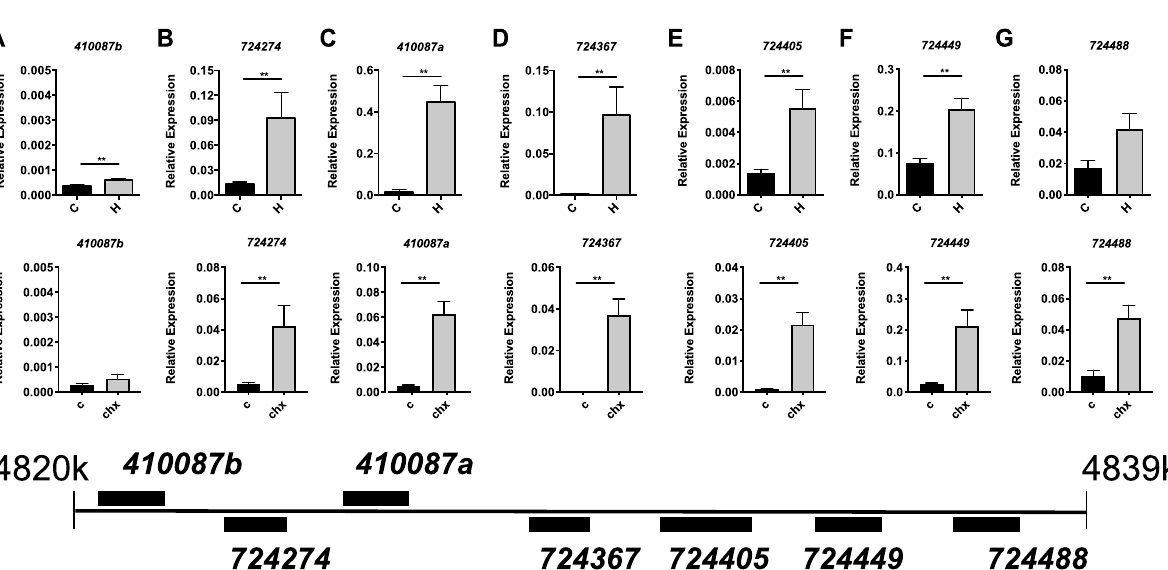
Figure 3. Select sHSP genes are induced during ISR induction. Transcript levels of the l(2)efl genes 410087b ( A ), 724274 ( B ), 410087a ( C ), 724367 ( D ) , 724405 ( E ), 724449 ( F ), and 724488 ( G ) relative to β-actin in midgut tissue from adult bees captured at the landing board and fed sucrose solution containing halofuginone (H, n = 8) or vehicle alone (C, n = 8) for 24 h (top row). Transcript levels of these same genes relative to β-actin in midgut tissue from adult bees captured at the landing board and fed sucrose solution alone (C, n = 8) or with 0.5 mg/ ml cyclohexamide for 48 h (chx, n = 8) (bottom row). A schematic diagram of the colocalized l(2)efl genes in the honey bee genome is shown below for reference. Mean ± SEM is shown and represents expression values of the genes of interest calculated using the 2 (−ΔCT) method for individual bees. Statistical significance is noted as *p < 0.05, and **p <